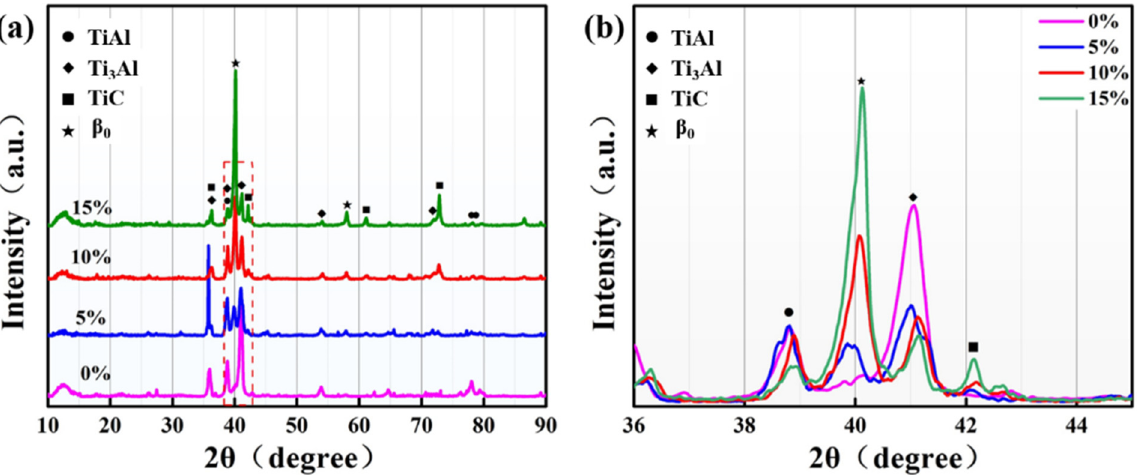
Figure 3. ( a ) XRD patterns of coatings with different WC contents. ( b ) Local enlargement of the XRD patterns of added coatings with different WC content. patterns of added coatings with different WC